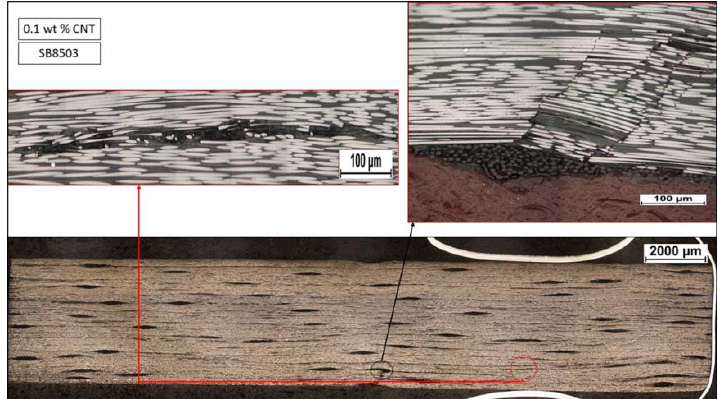
Figure 7. Micrograph of 0.1 wt% CNT suspension-treated CF fabric short beam shear specimen after the test. The ( Bottom ) image shows an overview of the part of the specimen. The ( Upper ) images indicate the fiber kinking formed during the failure.